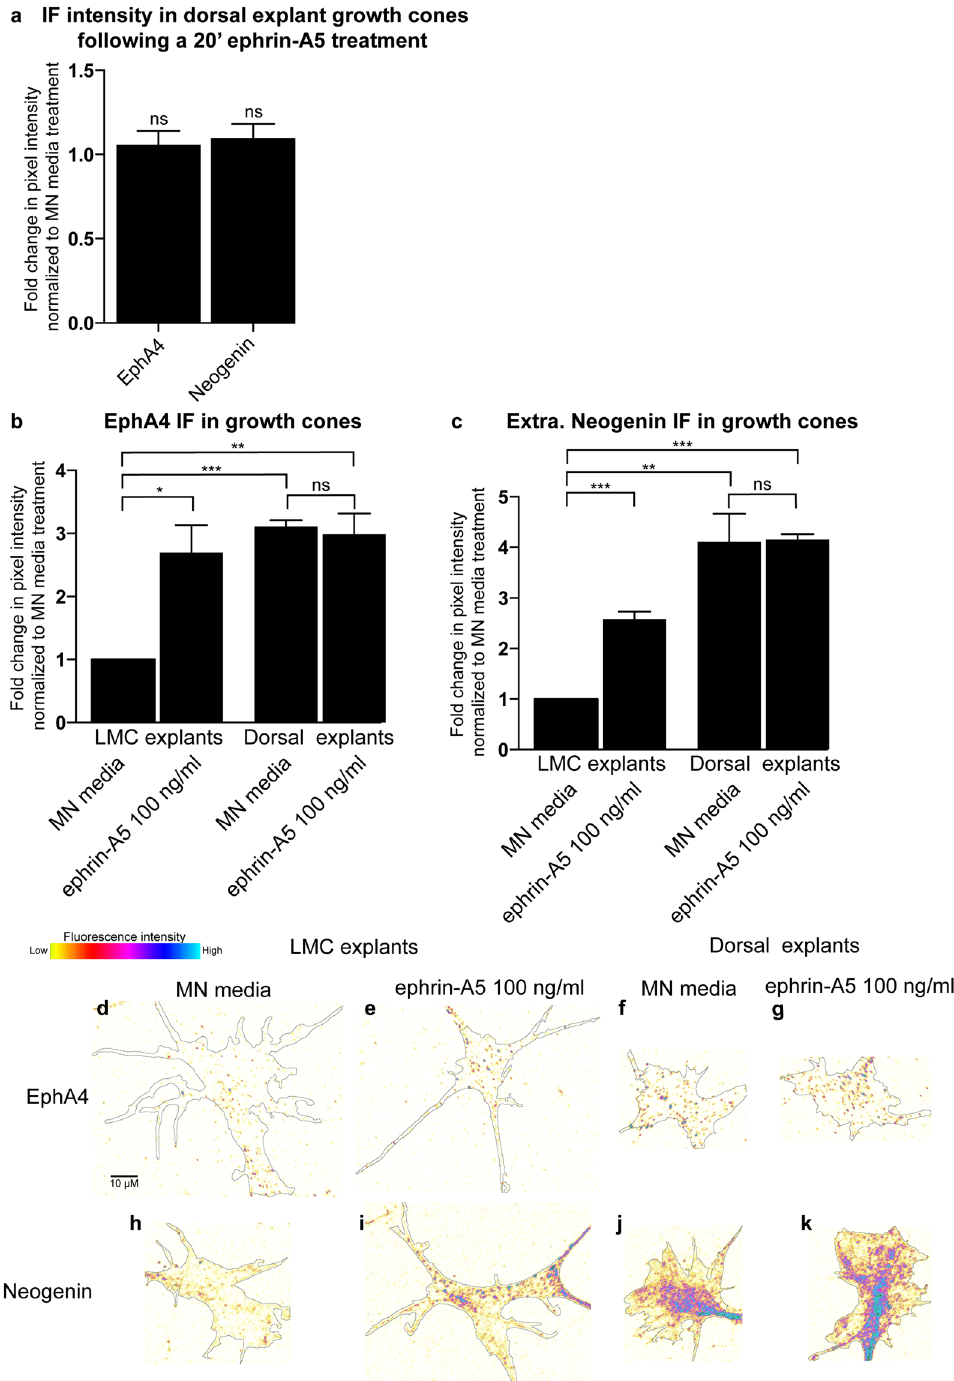
Figure 5. Ephrin-A5 fails to increase Neogenin or EphA4 protein levels in growth cones of dorsal spinal cord explants. ( a ) Quantification of the mean Neogenin and Epha4 IF in growth cones of dorsal lumbar spinal cord explants treated with ephrin-A5 100 ng/mL for 20 ′ (p = 0.835 and p = 0.825 respectively). ( b , c ) A comparison of Neogenin and EphA4 IF levels between growth cones of LMC and dorsal spinal cord explants shows that EphA4 and Neogenin IF is greater in dorsal explants (3.1 ± 0.1-fold, p = 0.00003 and 4.11 ± 0.6-fold, p = 0.0049 respectively). Whereas ephrin-A5 increases EphA4 and Neogenin IF levels in LMC explants (2.7 ± 0.4- fold, p = 0,018; 2.6 ± 0.2-fold, p = 0,0005 respectively), EphA4 and Neogenin IF in dorsal explants remains unchanged (p = 0.734 and p = 0.949). ( d , K ) Examples of growth cones quantified in ( b , c ). Data are shown as mean ± SEM, statistical significance was tested using a two-tailed unpaired sample t-test. ( a ) MN media N = 6, ephrin-A5 N = 6; ( b , c ) MN explants/MN media N = 3, MN explants/ephrin-A5 N = 3, Dorsal explants/MN media N = 3, Dorsal explants/ephrin-A5 N =